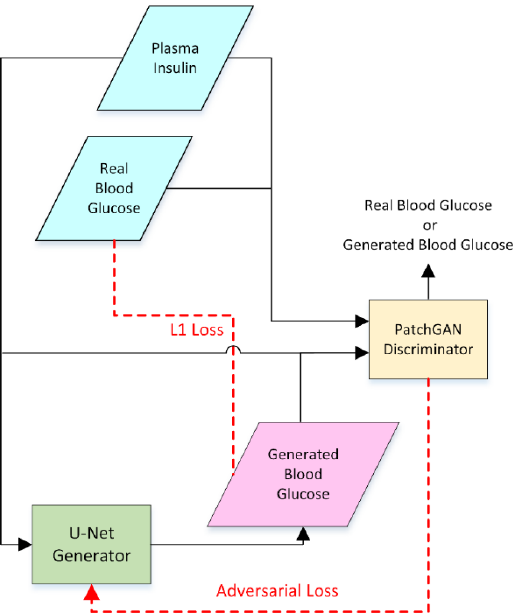
Figure 2. Pix2Pix generative adversarial network architecture in training configuration for translation of plasma insulin images into blood glucose